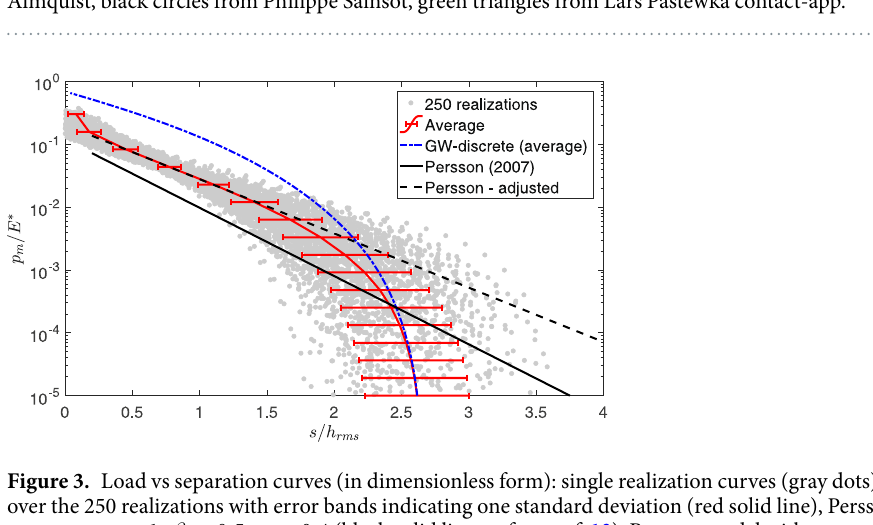
Figure 2. Load vs separation curve for the test surface of Fig. 1a. Red stars symbol indicate the multiasperity code compared with three BEM codes (all with periodic boundary conditions): blue squares from Andreas Almquist, black circles from Philippe Sainsot, green triangles from Lars Pastewka contact-app.